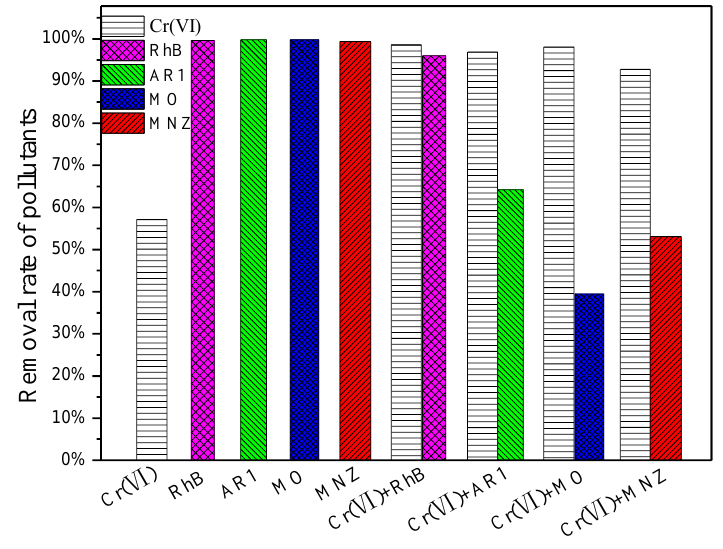
Figure 9. Photocatalytic treatment of single and binary pollutant system by Ga 2 O 3 .